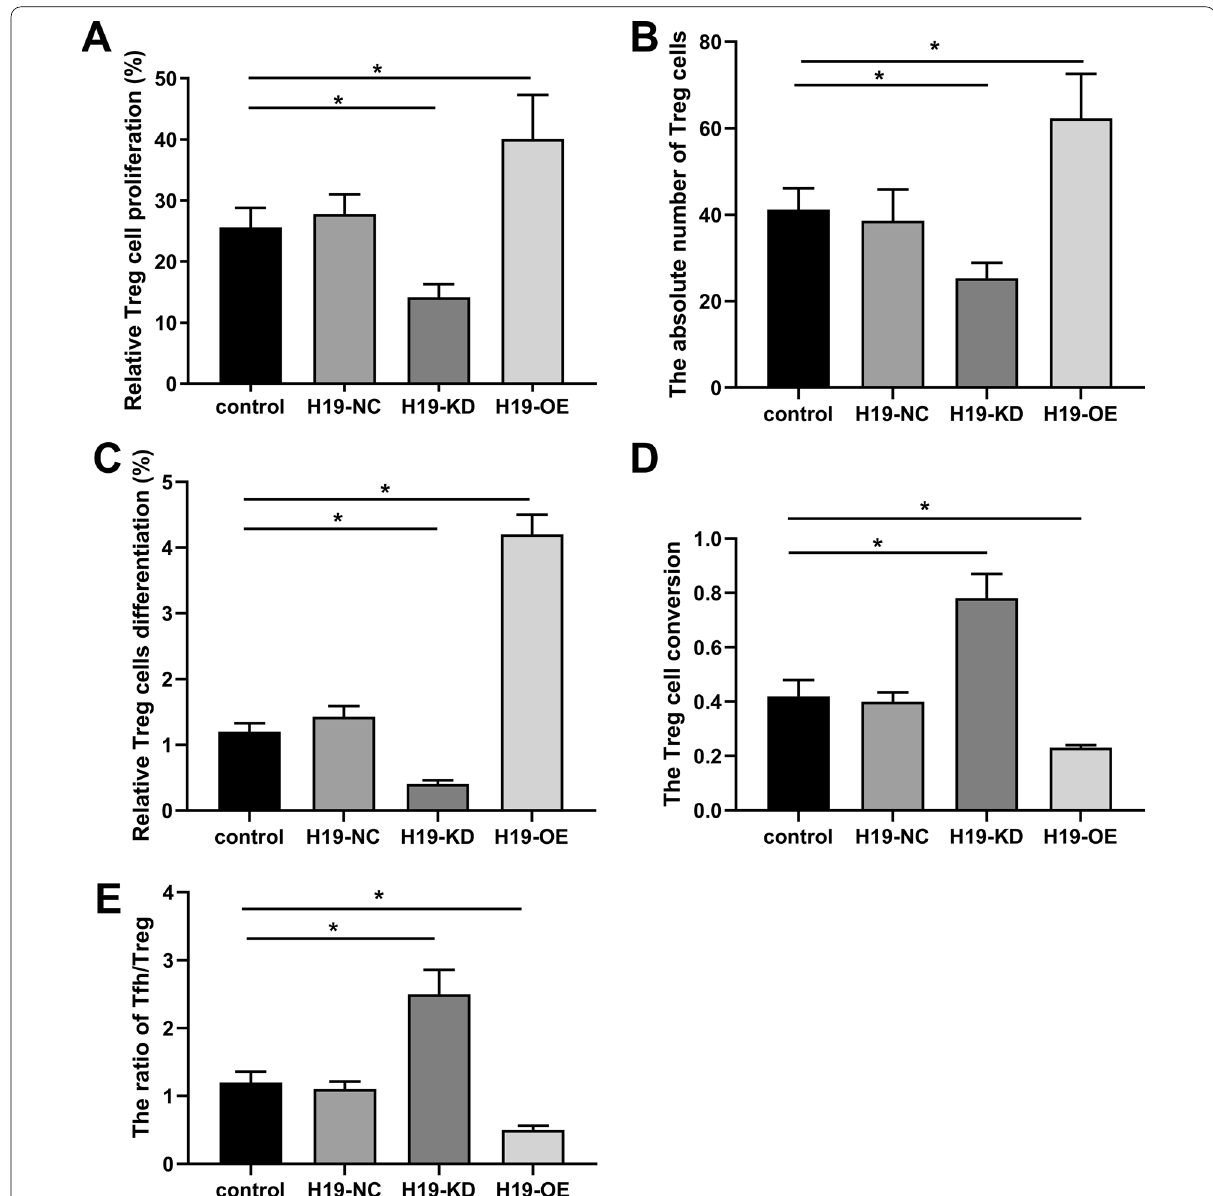
Fig. 4 H19 inhibited Treg cell proliferation and promoted its differentiation to Tfh cells. BMMSCs were transfected with H19-NC, H19-OE or H19-KD and then co-cultured with Treg cells at a ratio of 1:10 for 3 days. H19-OE suppressed Treg cell proliferation ( A ) and absolute number ( B ). C H19-OE transfected BMMSCs decreased Treg cell differentiation. D H19-OE promoted the conversion of Treg cells to Tfh cells. E The ratio of Tfh/Treg was increased in the H19-OE. n 6. *P < =